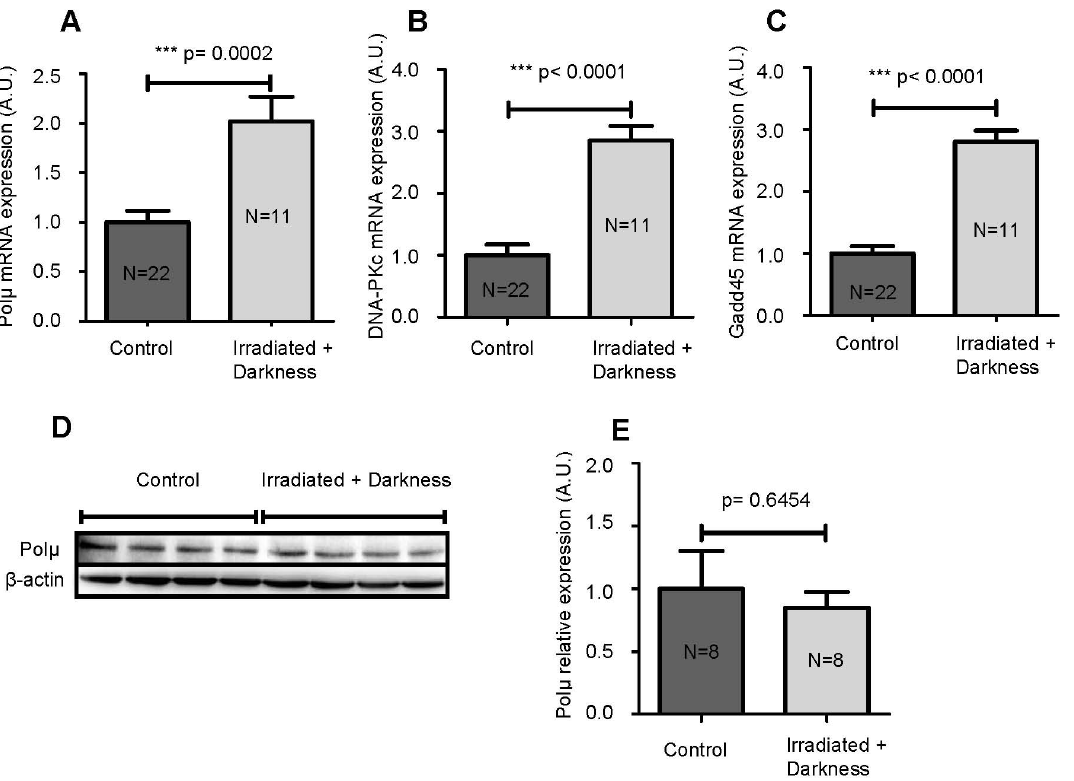
Figure 4. Effects of the combination of space radiation and darkness. Pol m ( A ), DNA-PKc ( B ) and Gadd45 ( C ) mRNAs were quantified by qPCR in larvae that developed in the dark and under the simulation of ISS radiation. Pol m proteins were quantified by western blotting ( D ). Each lane contains proteins from 3 larvae. Western blot results were analyzed and quantified by densitometry using a Fusion Fx7 imaging system (Vilber Lourmat, Marne-la-Valle´e, France) and Pol m expression was normalized to b -actin ( E ). Results are expressed as the mean 6 SEM. ‘‘A.U.’’ stands for ‘‘arbitrary units’’.